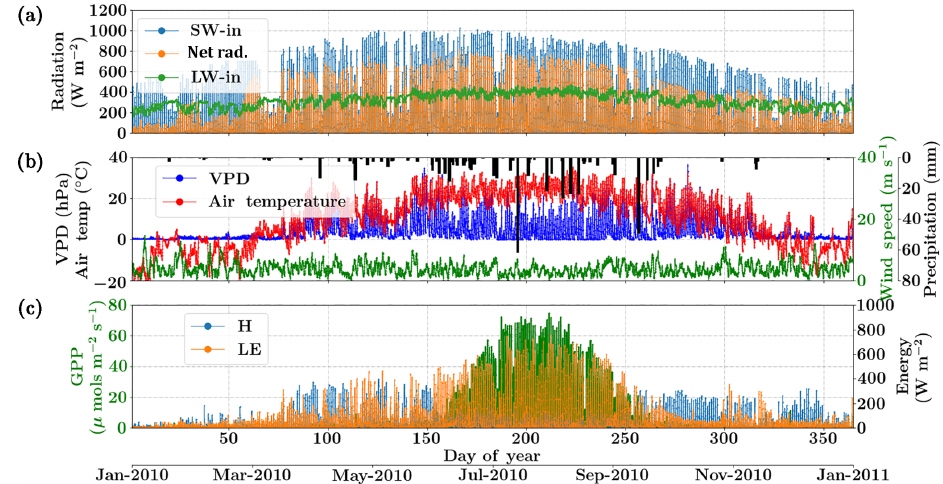
Figure 6. Figure showing the diurnal and seasonal variability of important environmental and meteorological forcings together with the tower observed fluxes of carbon and energy used in SCOPE model inversions for the Nebraska Mead flux tower site. The variables in (a) and (b) are used as inputs to the SCOPE model and the variables in (c) are used as a target in a moving window retrieval approach. Table 1. Prior values for LM inversion (units: V cmax , µmolsm − 2 s − 1 ; BB slope , no unit; LAI, no